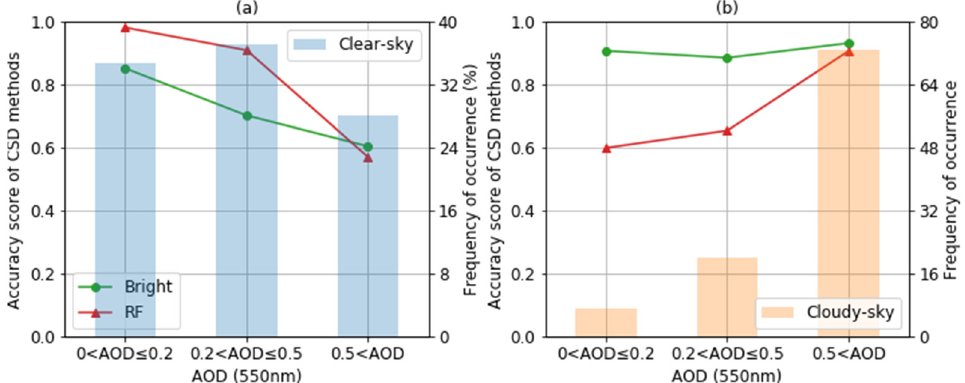
Figure 7. Accuracy score of the Bright-Sun (the green line) and RF CSD model (the red line) under clear-sky ( a ) and cloudy-sky ( b ) conditions, and the frequency of occurrence for each AOD background.